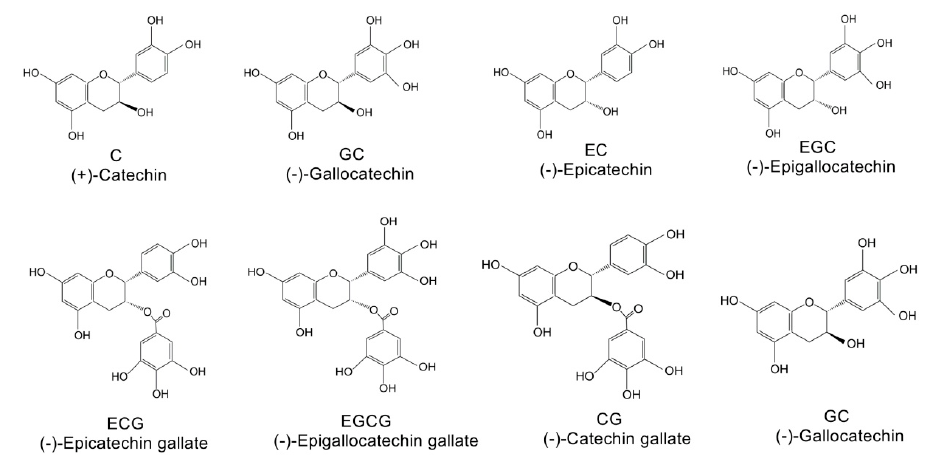
Fig. 1: Chemical structure of 8 major